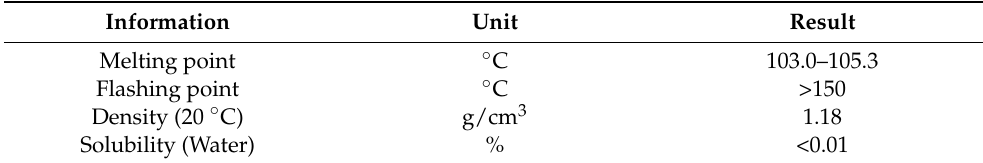
Figure 2. The decomposition chemical equation of UV-5411. Table 5. Basic physical properties of UV-5411.